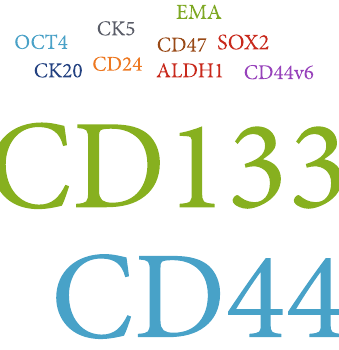
Figure 2: Word cloud: visualization of the surface markers for bladder